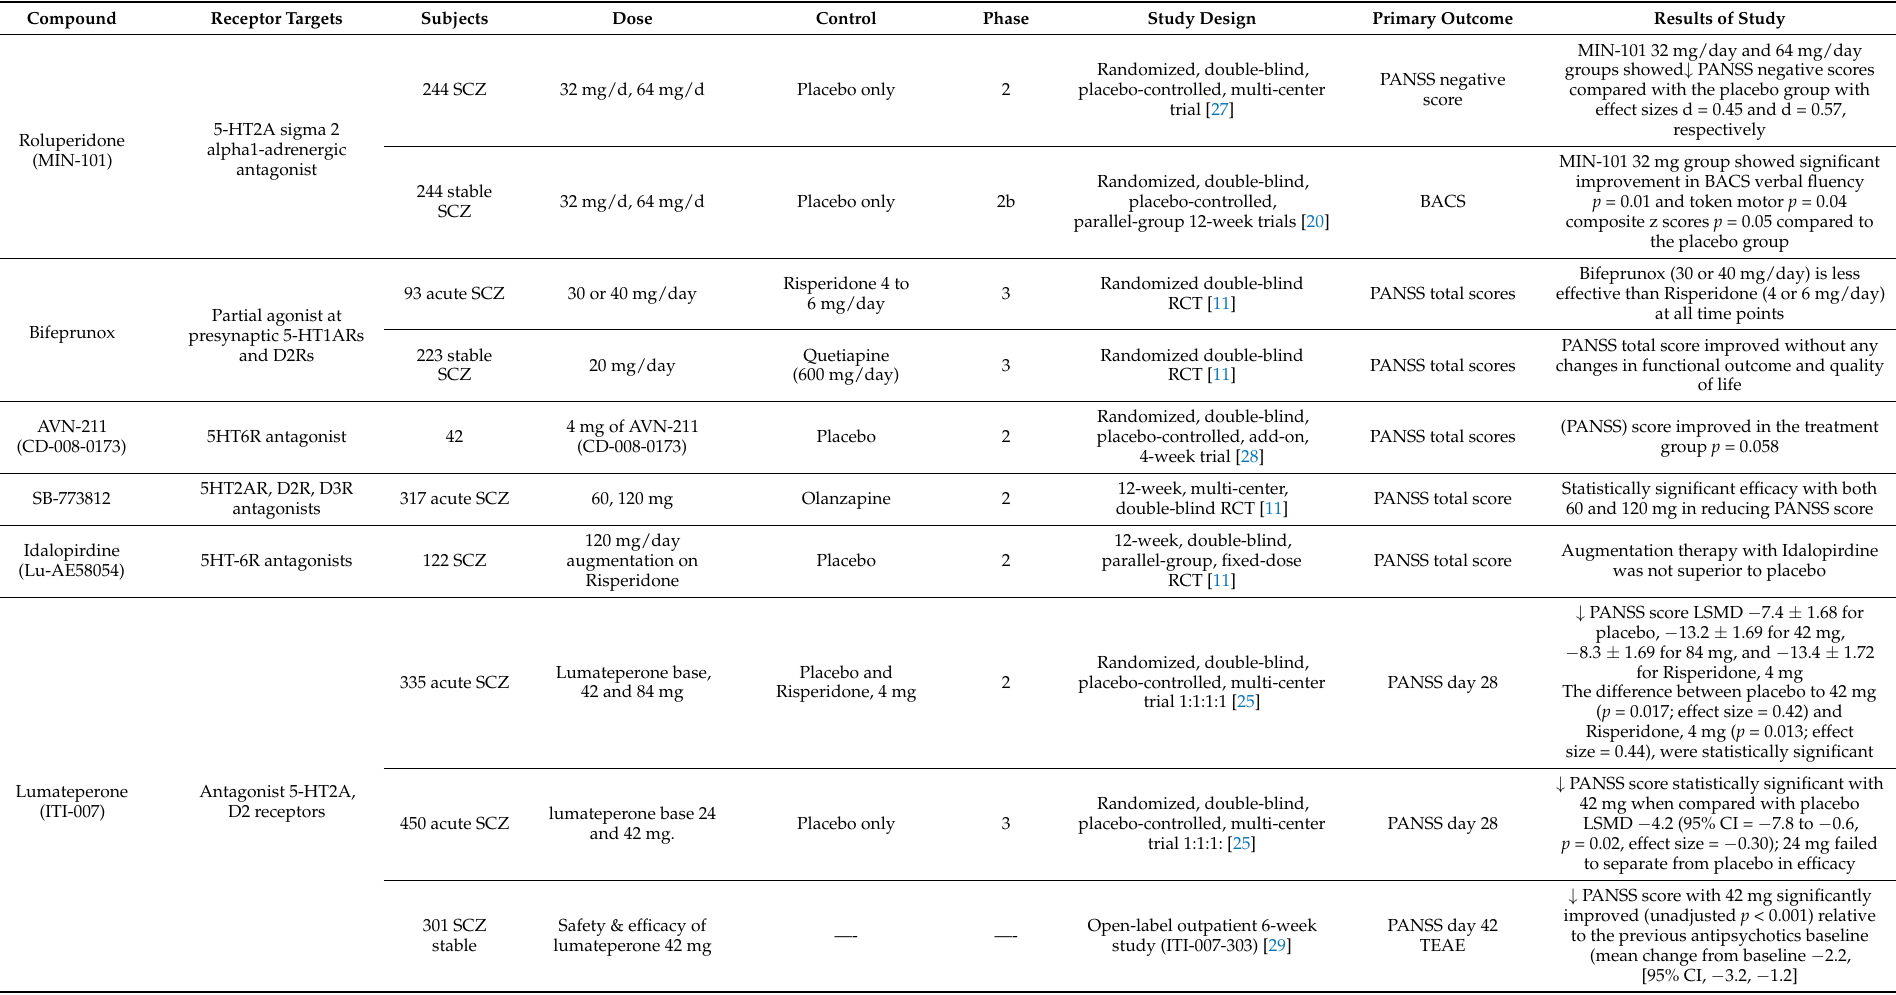
Table 2. Modulators Predominantly Affecting Serotonergic